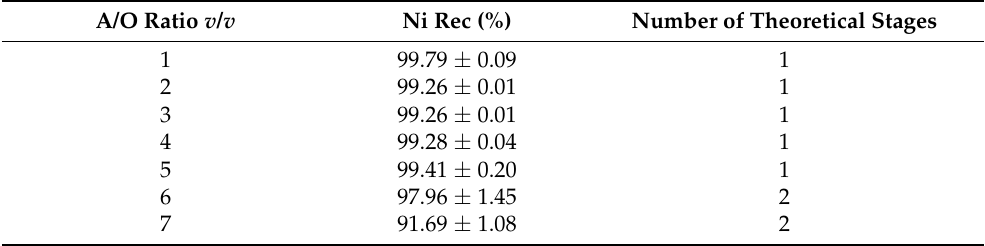
Figure 9. Extraction isotherm of Ni using LIX ® 84-I 10% v/v , pH 5, McCabe-Thiele plot is shown for A/O ratio 7. Table 10. Ni extraction rate and theoretical stages required for complete extraction at different A/O ratios (LIX ® 84-I 10% v/v , feed solution 0.13 g/l, pH 5).